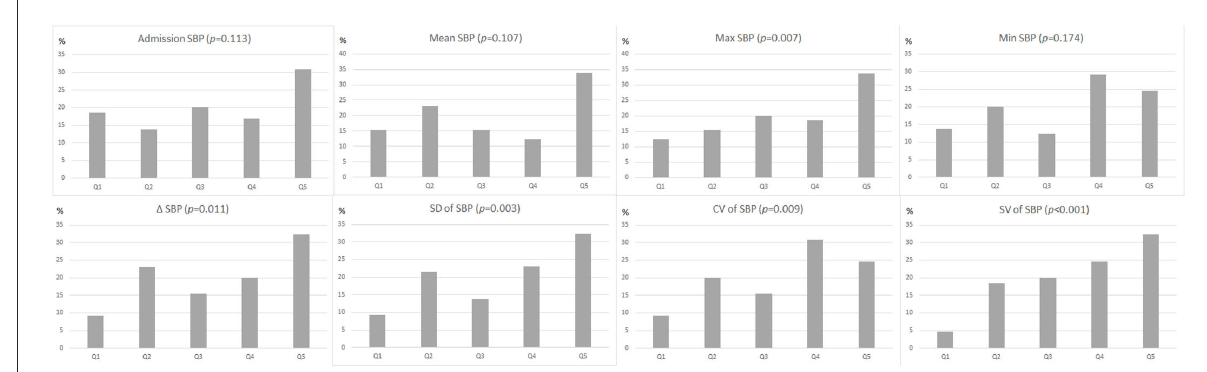
FIGURE2 Proportion (as a percentage) of patients with R-DWILs according to quintiles (Q1: lowest quintile group, Q5: highest quintile group) of each blood pressure variability parameter. The p -values are for the χ 2 test for linear trend.